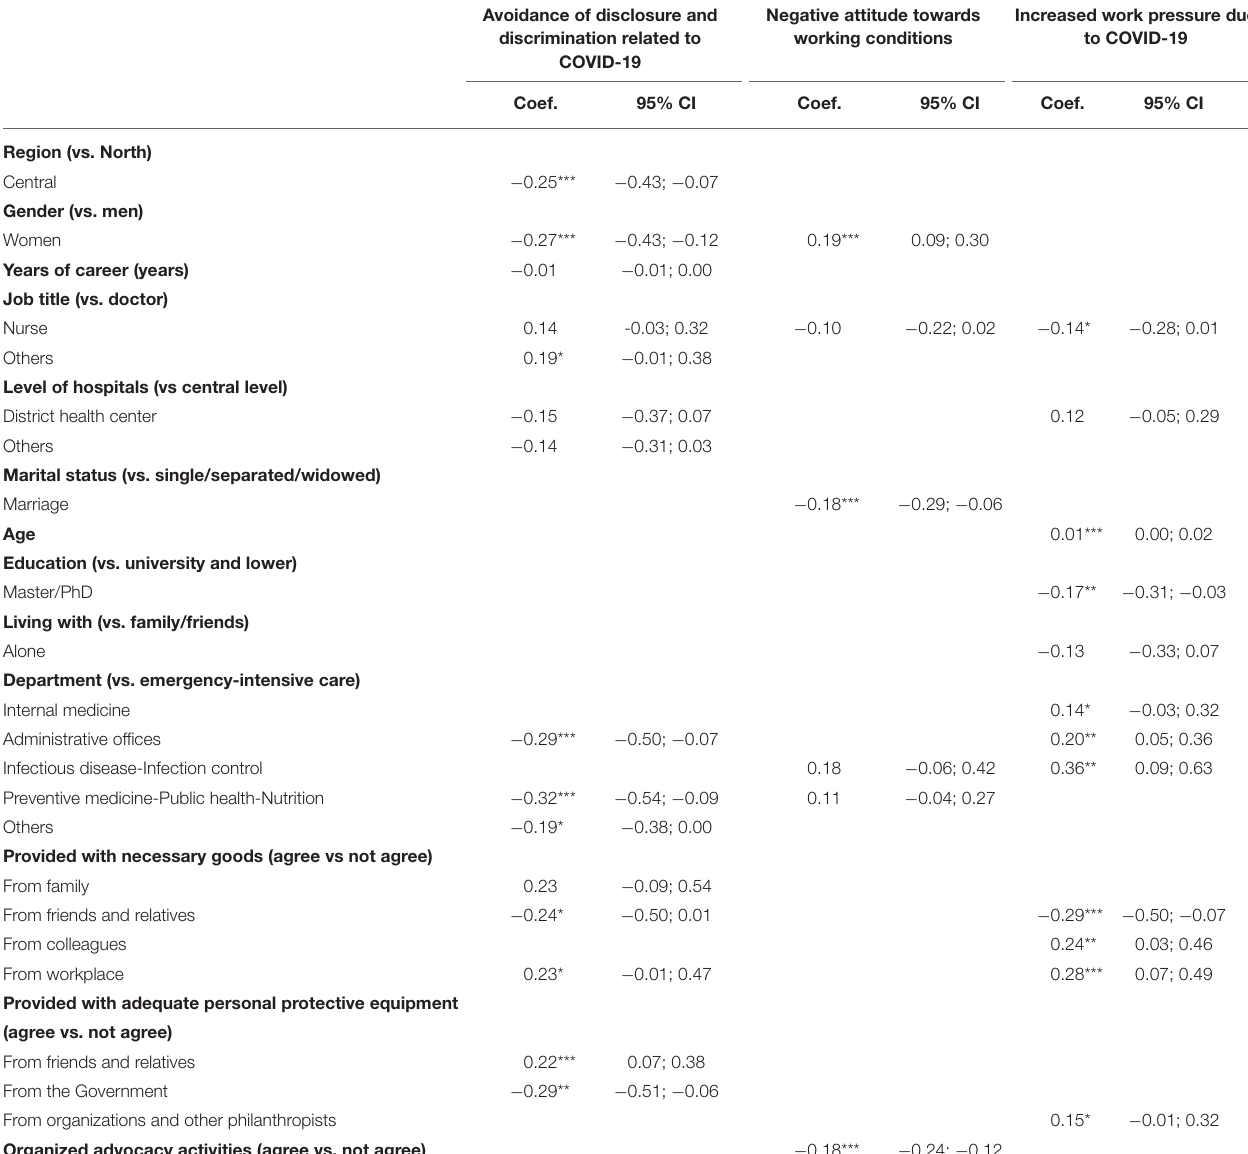
TABLE 4 | Multivariate regression for identifying factors associated with perception on life and job impacts due to COVID-19.